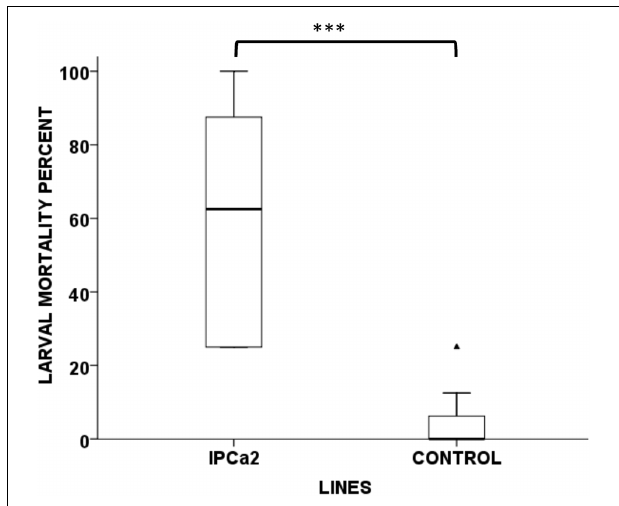
FIGURE 3 | Whole plant bioassay of transgenic chickpea line IPCa2 compared to control. Box plot indicating significant differences between the